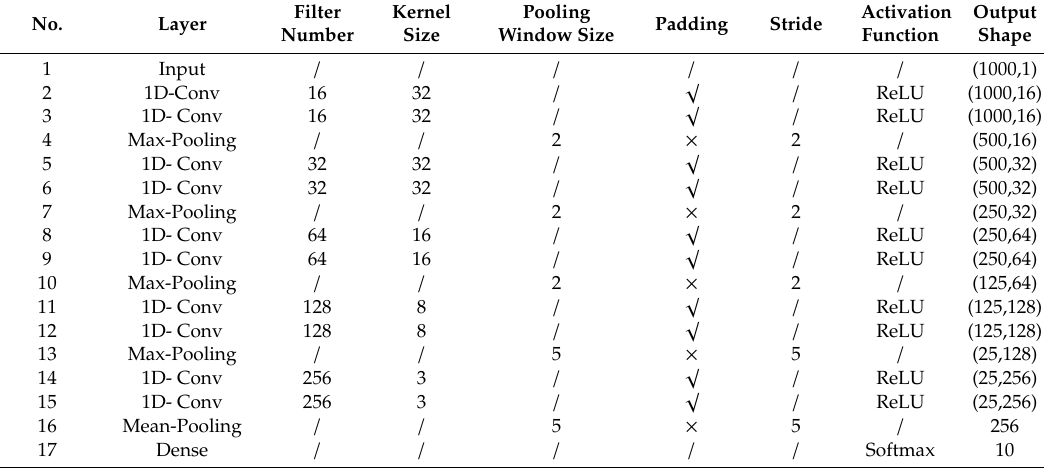
Table 1. Model parameters.